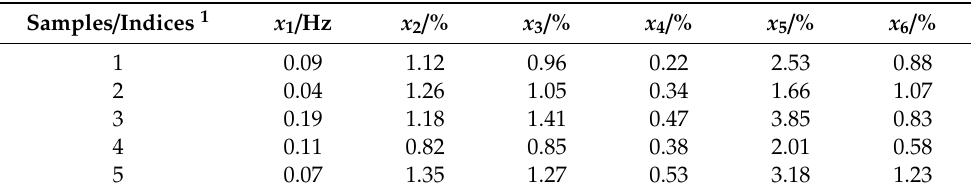
Table 3. Measured PQ